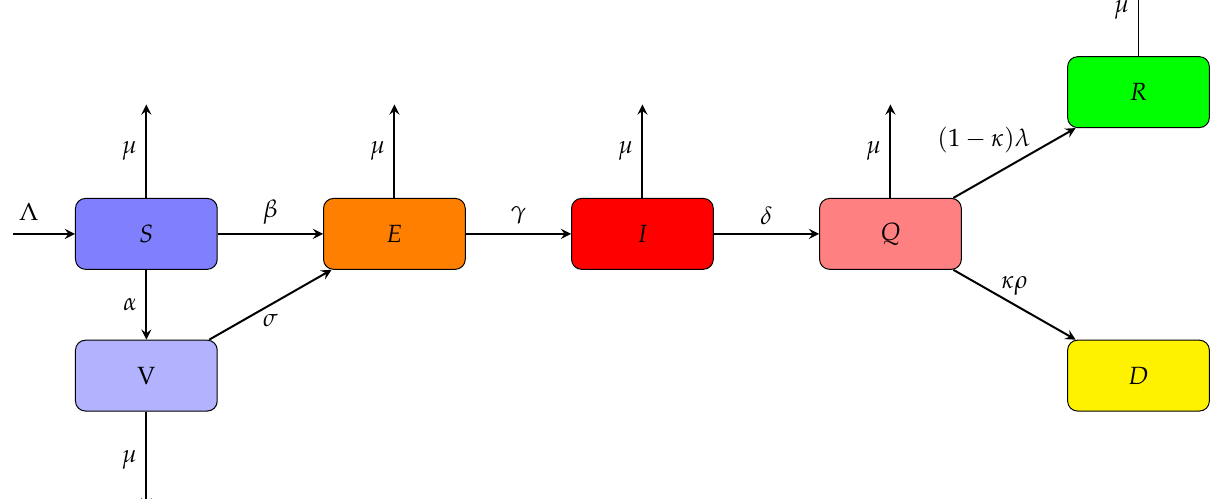
Figure 1. Disease transmission flow of the proposed